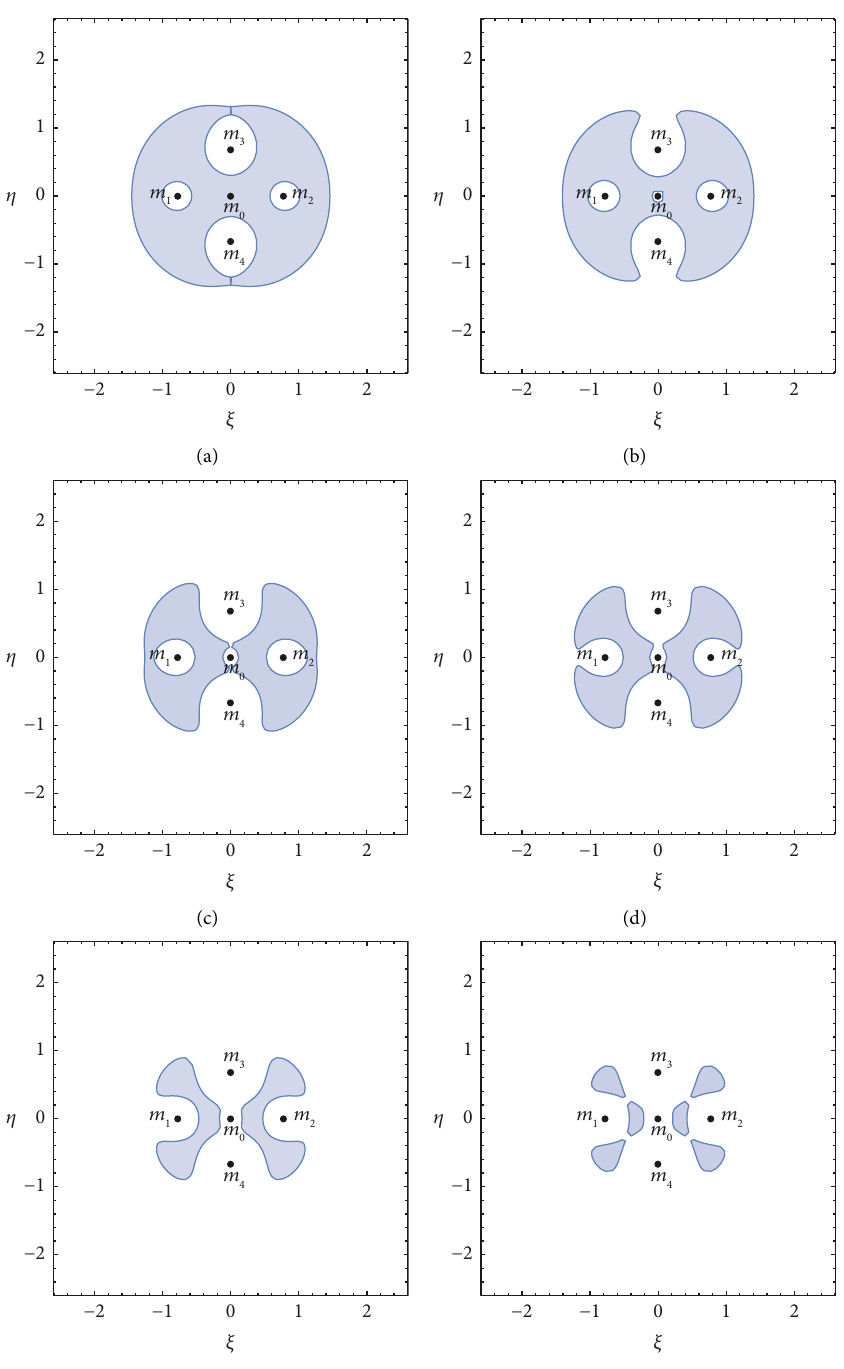
Figure 9: The permitted (white) and prohibited (shaded) regions of motion of m (a) C � − 1 . 78, (b) C � − 1 . 74, (c) C � − 1 . 66, (d) C � − 1 . 64, (e) C � − 1 . 58, and (f) C � − 1 .